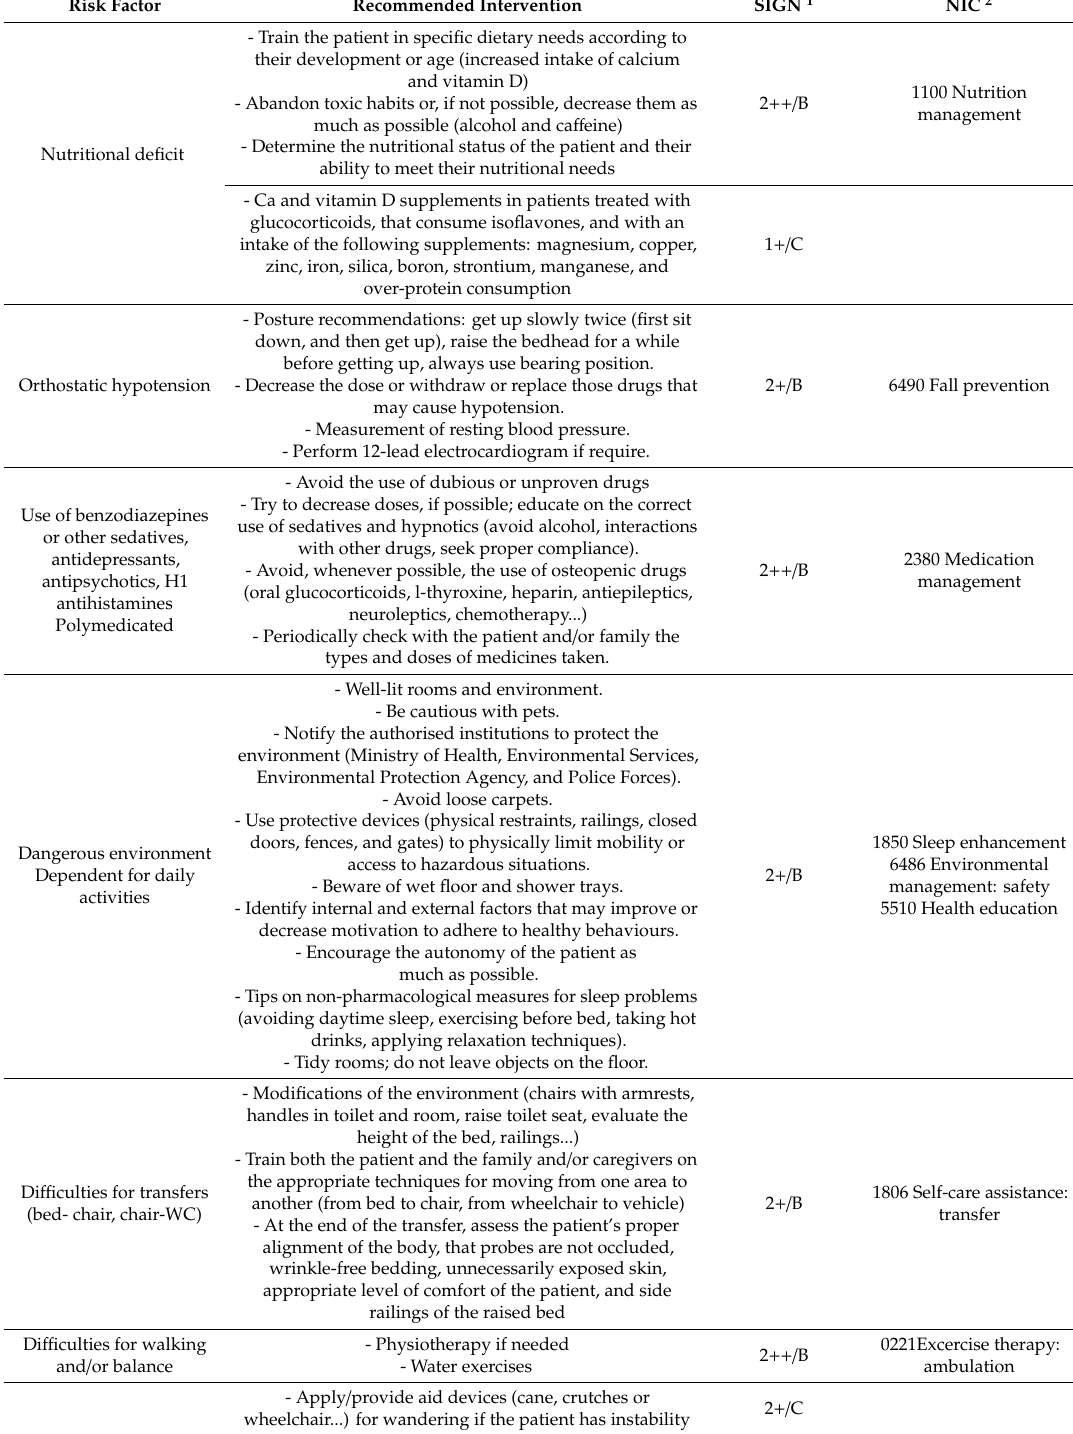
Table 6. Recommended interventions related to the Nursing Interventions Classification. Risk